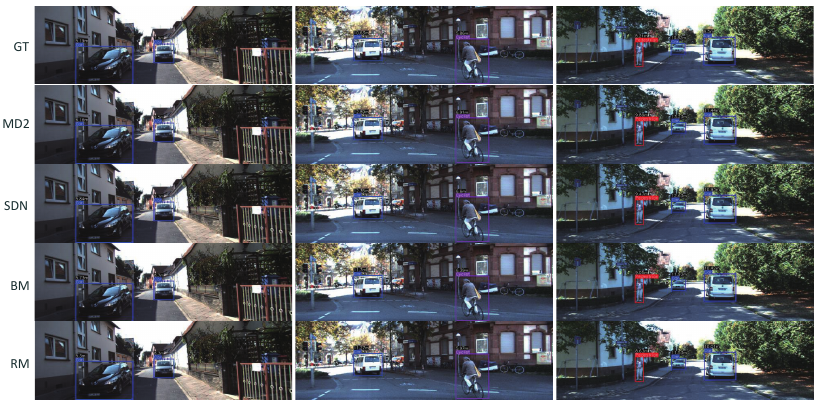
Figure 8. Examples of the estimated distance using our proposed base model (BM) and robust model (RM). We also provide ground truth distance (GT), Monodepth2 (MD2), and SynDistNet (SDN) for comparison.